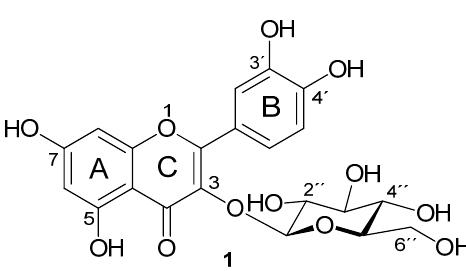
Figure 1. Isoquercitrin ( 1 , quercetin-3- O - β - D -glucopyranoside).